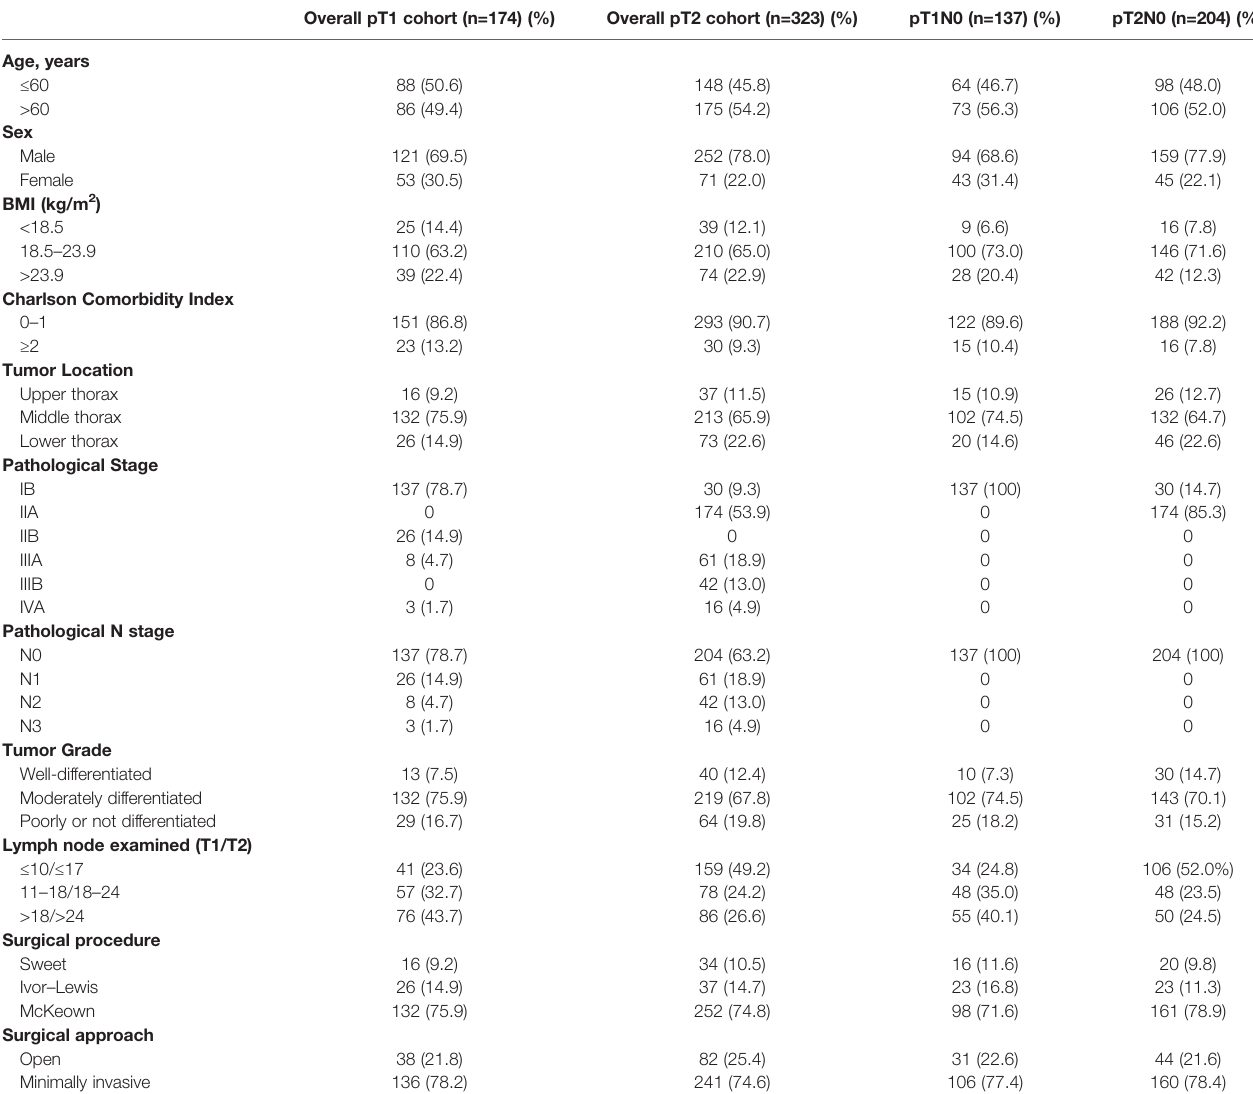
TABLE 1 | Clinicopathologic characteristics of pT1 and pT2 ESCC patients. Overall pT1 cohort (n=174)